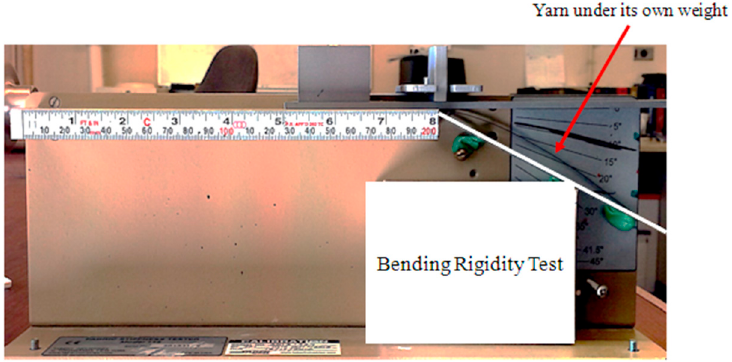
Figure 12. The experimental set-up used for measuring effective bending rigidity of the yarn.